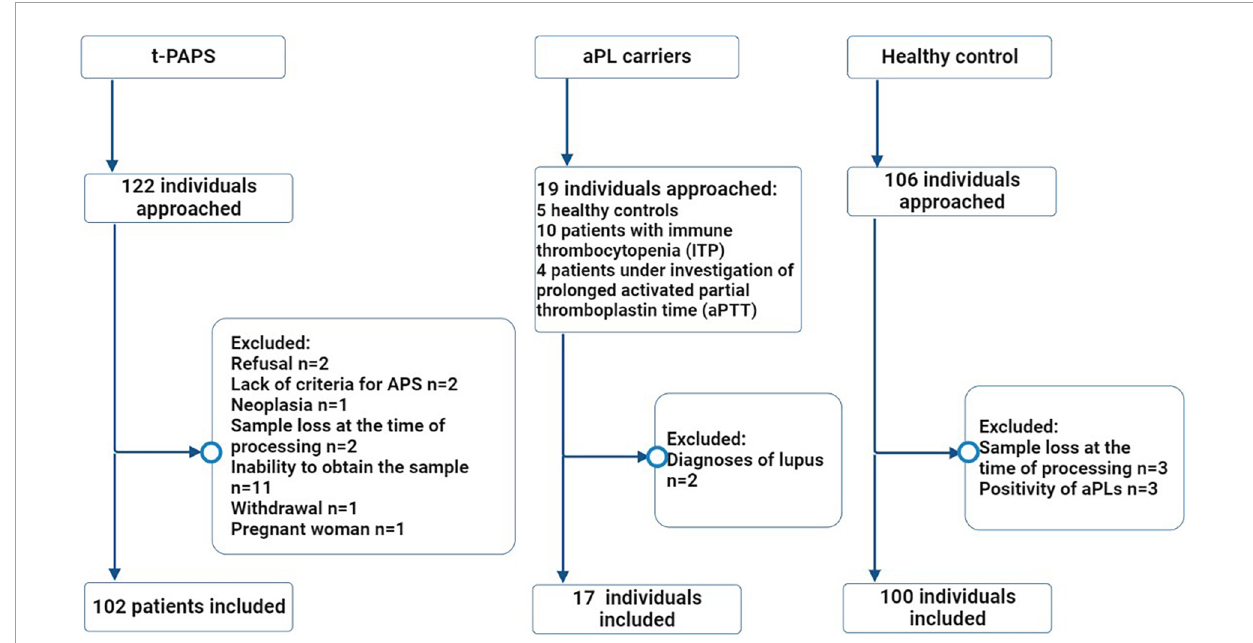
FIGURE1 Flowchart of the selection process of study participants. Legend: The flowchart illustrates the number of individuals who were approached ( n = 247), the excluded participants and the reasons for exclusions, the final number of individuals who were included in the study ( n = 219) and the distribution between the groups. t-PAPS, primary thrombotic APS; aPL, antiphospholipid antibodies; *n, absolute